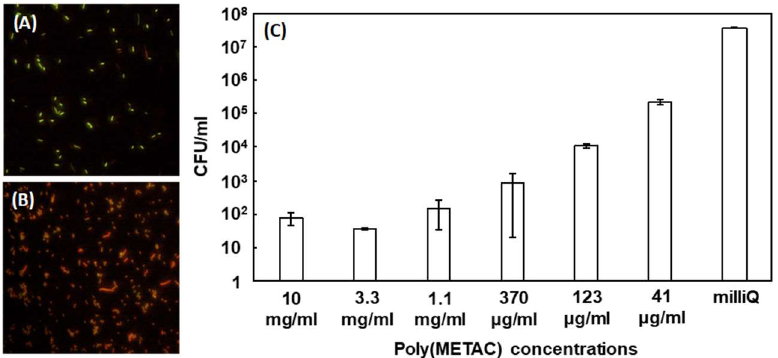
Figure 3. LIVE/DEAD test of E. coli in ( A ) milliQ and ( B ) 1 wt % of poly(METAC). The E. coli were stained with SYTO9 and PI. ( C ) The survival test of E. coli in the presence of poly(METAC) at different concentrations. The exposed E. coli by poly(METAC) were washed using phosphate-buffered saline (PBS) and were spread on medium to count the number of survived E. coli cells.